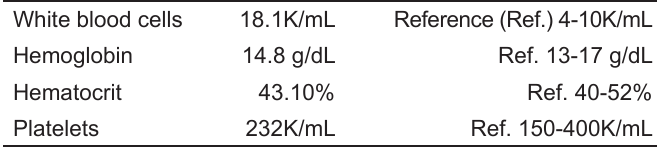
Table 1. Complete blood count results for patient presenting with severe abdominal